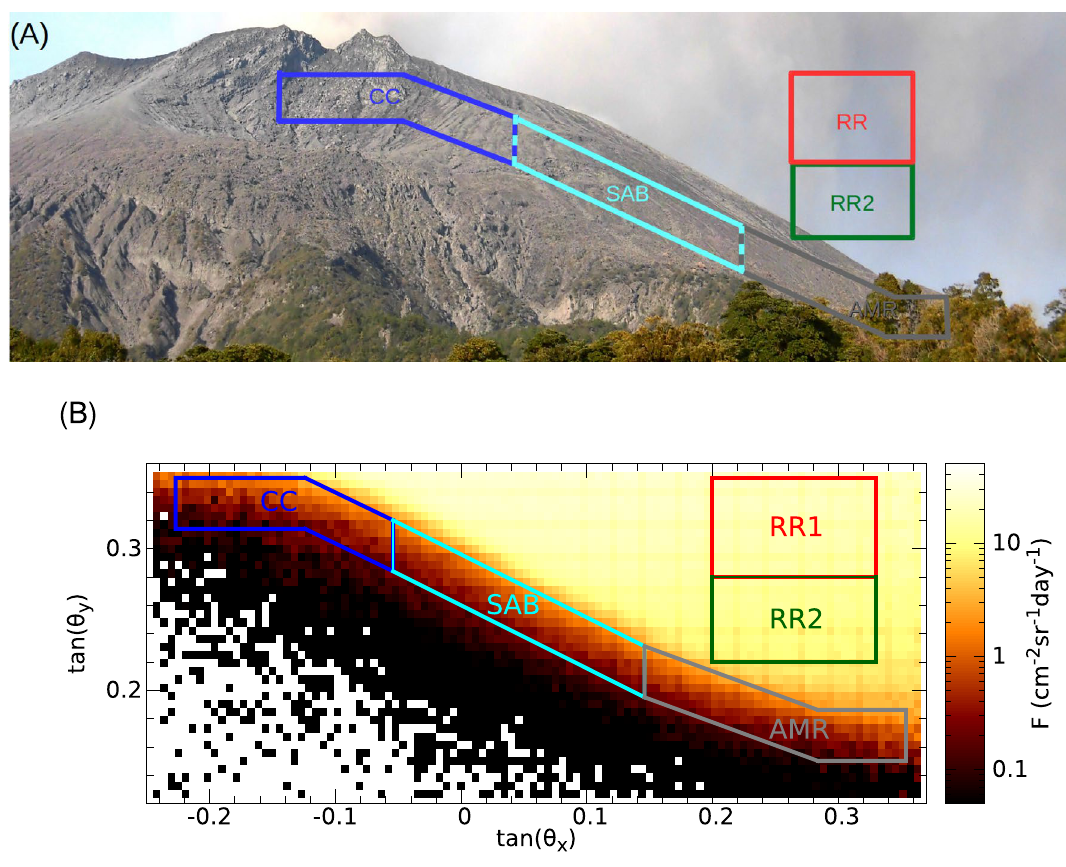
as a function of horizontal (tan( θ x )) and vertical (tan( θ y )) directions with an angular resolution of 5.5 mrad × 5.5 mrad for a period of 227 days. The white shaded regions without flux values represent very large thicknesses with inpractically low penetrated muon count. The coloured 2D-shapes show the designated angular regions for Reference Region (RR, red), Reference Region 2 (RR2, dark-green) Central Crater (CC, blue), Showa and Arimura Basin (SAB, cyan) and Arimura Middle Reaches (AMR, gray),